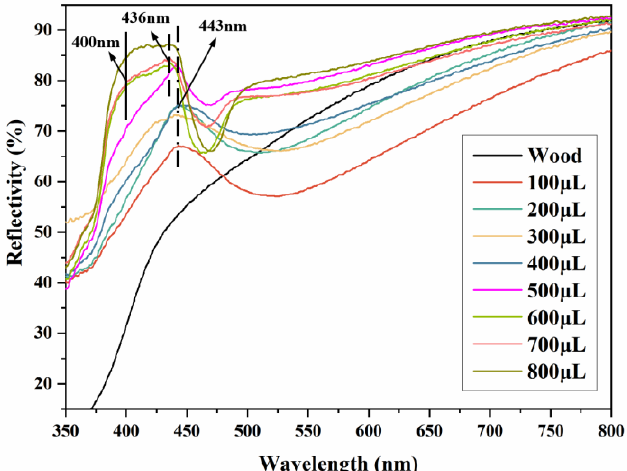
Figure 10. Reflection spectra of coatings formed by PSt emulsions with different amounts on a 35 mm × 35 mm wood surface. 35 mm × 35 mm wood